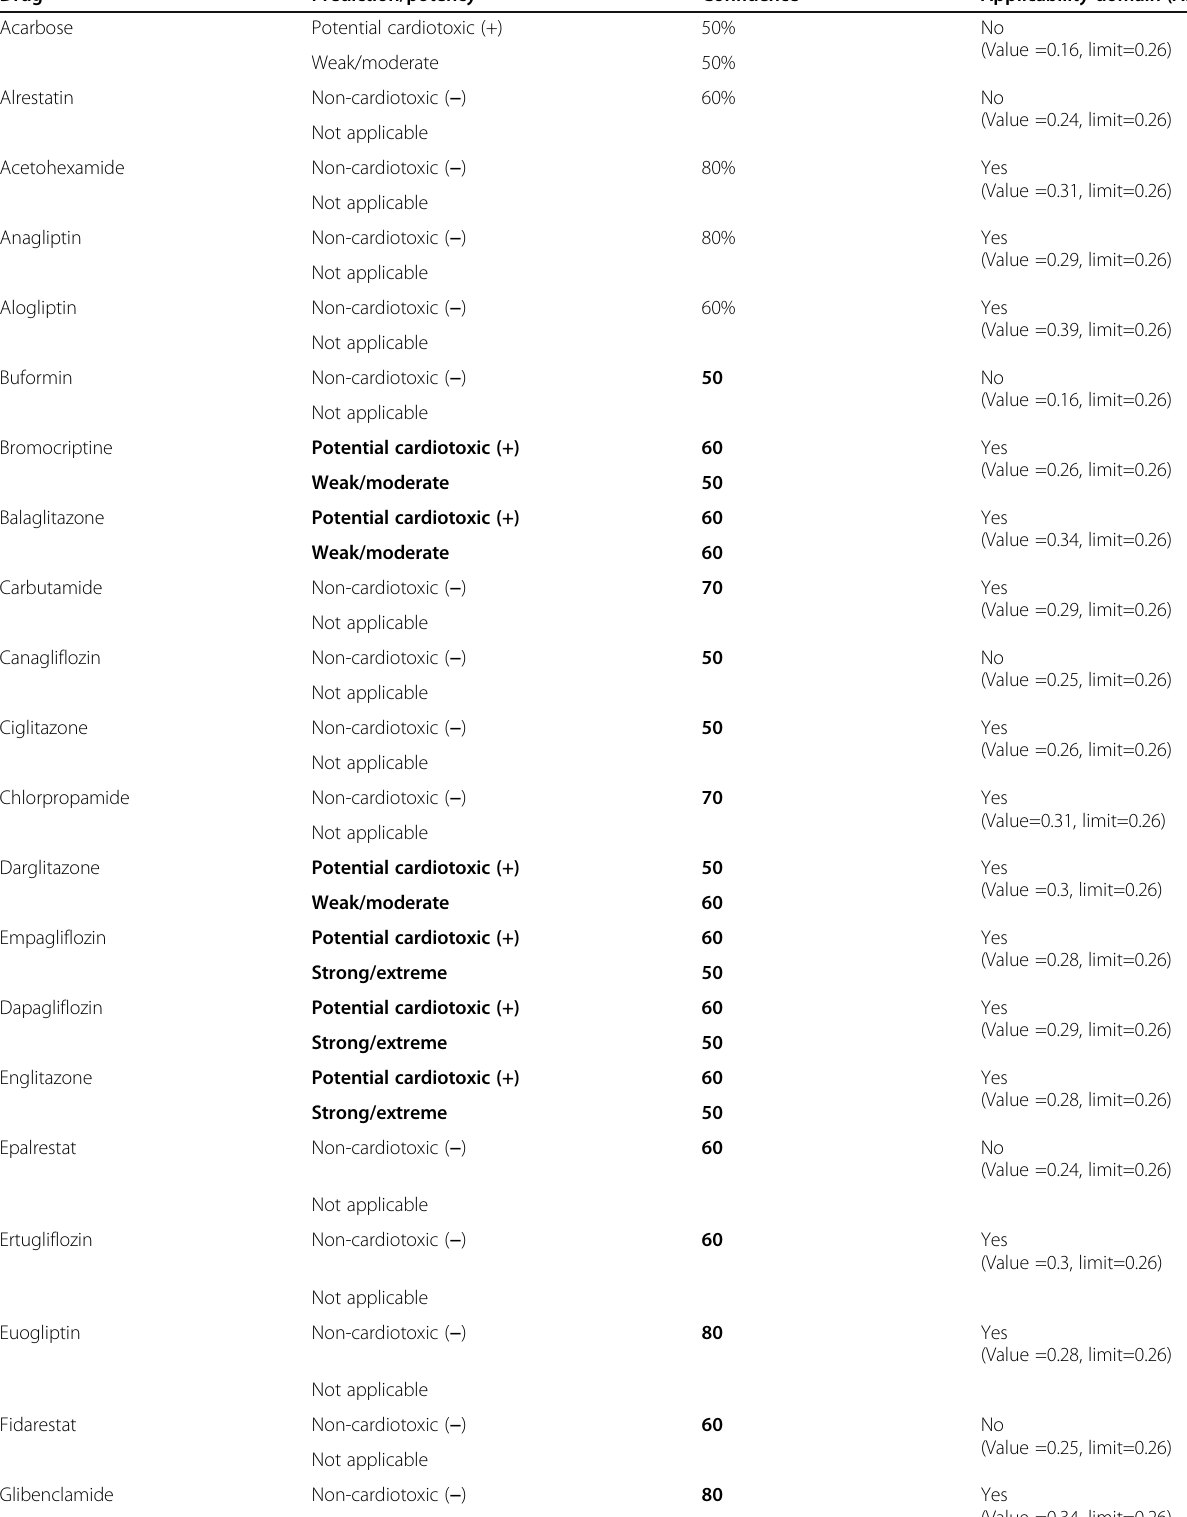
Table 1 Details of anti-diabetic compounds selected for study and their hERG blocking profile